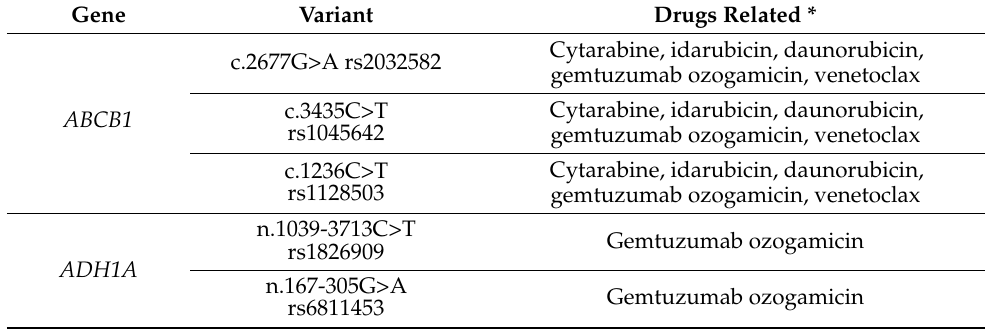
Table 3. Summary of the variants of interest for the drugs analyzed in this review. Gene